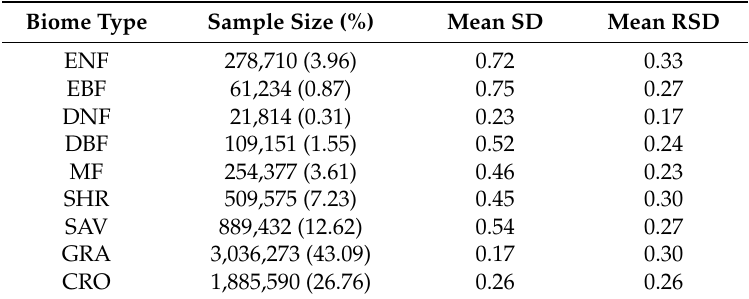
Table 4. Mean SD and RSD for each biome type.